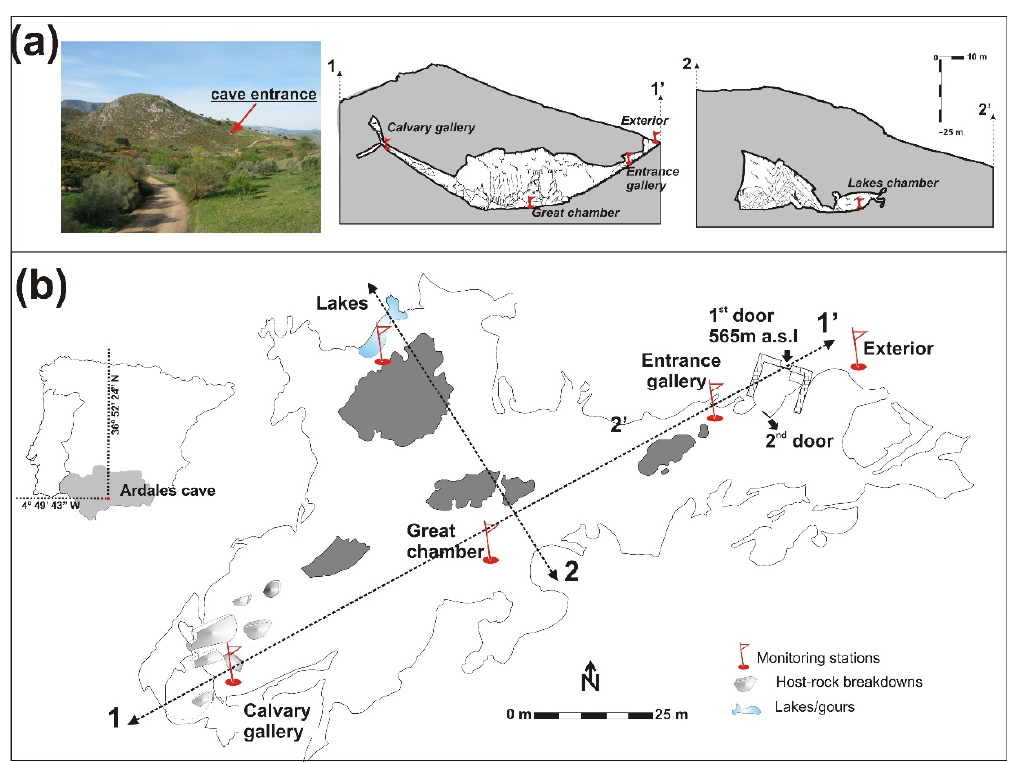
Figure 1. ( a ) Panoramic view of the carbonates outcrop hosting Ardales Cave and cross-sections comparing the cave dimensions with the surface topography. ( b ) Location and cave map with the monitoring stations.